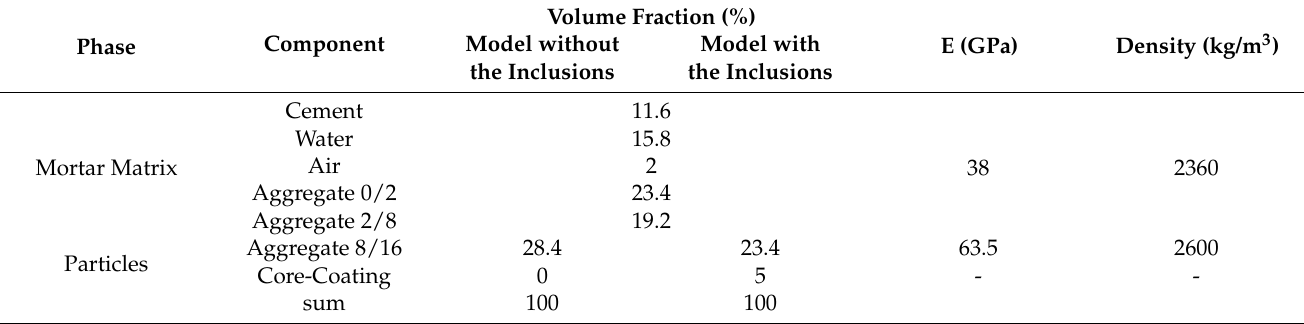
Table 7. The components of the meso-model as per the mix design of